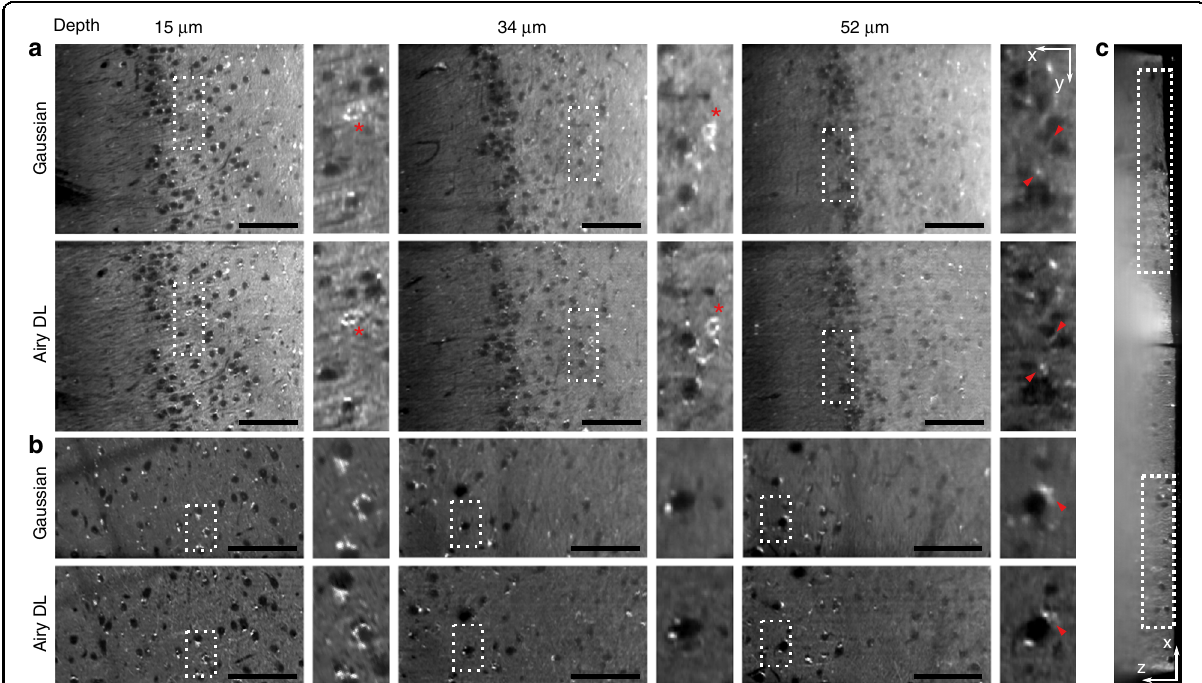
Fig. 6 Excised brain tissue from a mouse expressing enhanced YFP in parvalbumin-positive (PV + ) neurons. a , b Enface sections in-depth imaged using a Gaussian and Airy LSM with deep-learning deconvolution. Sections correspond to the a hippocampus and b deeper cortical regions. Insets to the right correspond to the regions marked by a dashed rectangle. Red asterisks mark PV + neurons. Red triangles mark regions that illustrate enhanced performance from the combination of an Airy beam and deep learning at depth. c Cross-sectional image ( z is depth) showing the regions displayed in ( a ) and ( b ). Scale bars are 100 μ